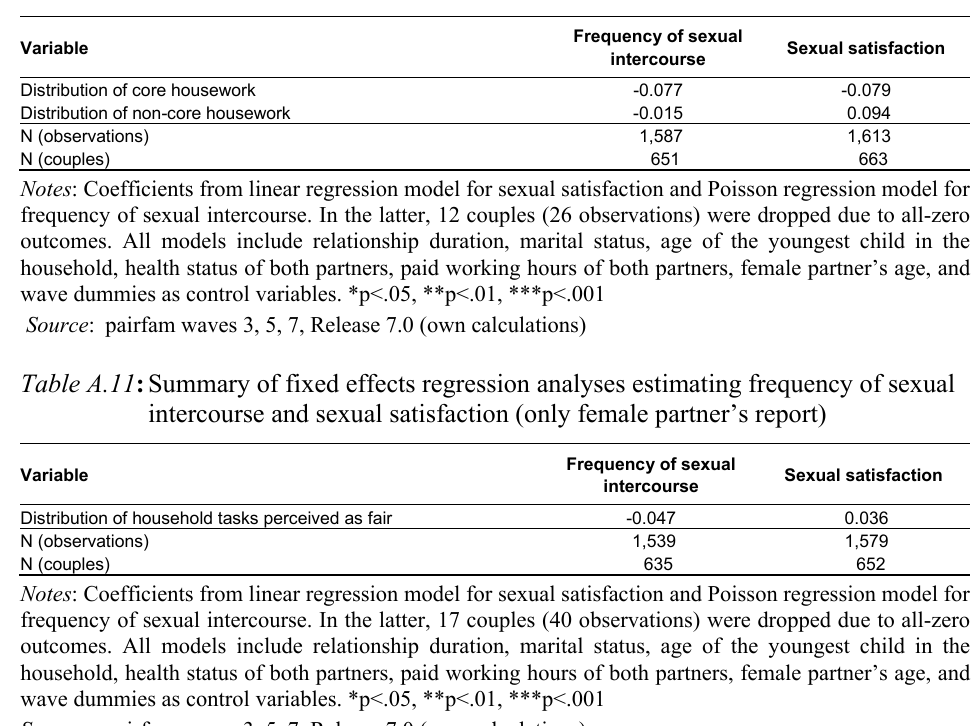
Table A.10 : Summary of fixed effects regression analyses estimating frequency of sexual intercourse and sexual satisfaction (only male partner’s report)